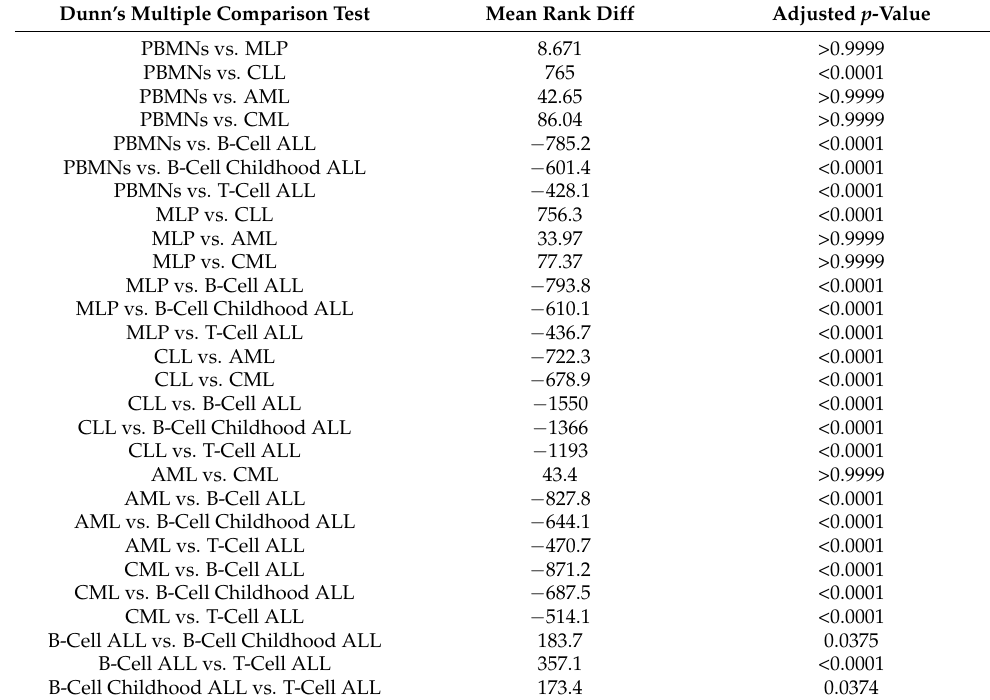
Table A1. Pairwise comparisons of UHRF1 mRNA expression between normal blood precursors and different subsets of